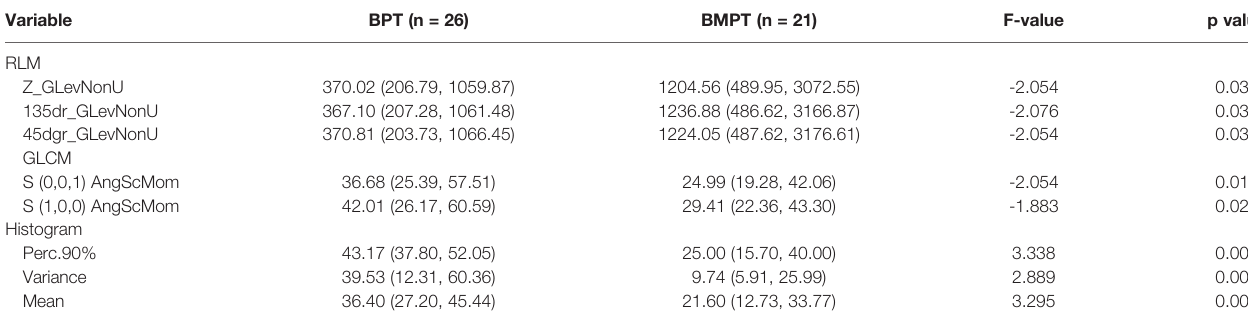
TABLE 2 | Comparisons of texture features from DCE-MR images between BPT and BMPT groups. Variable